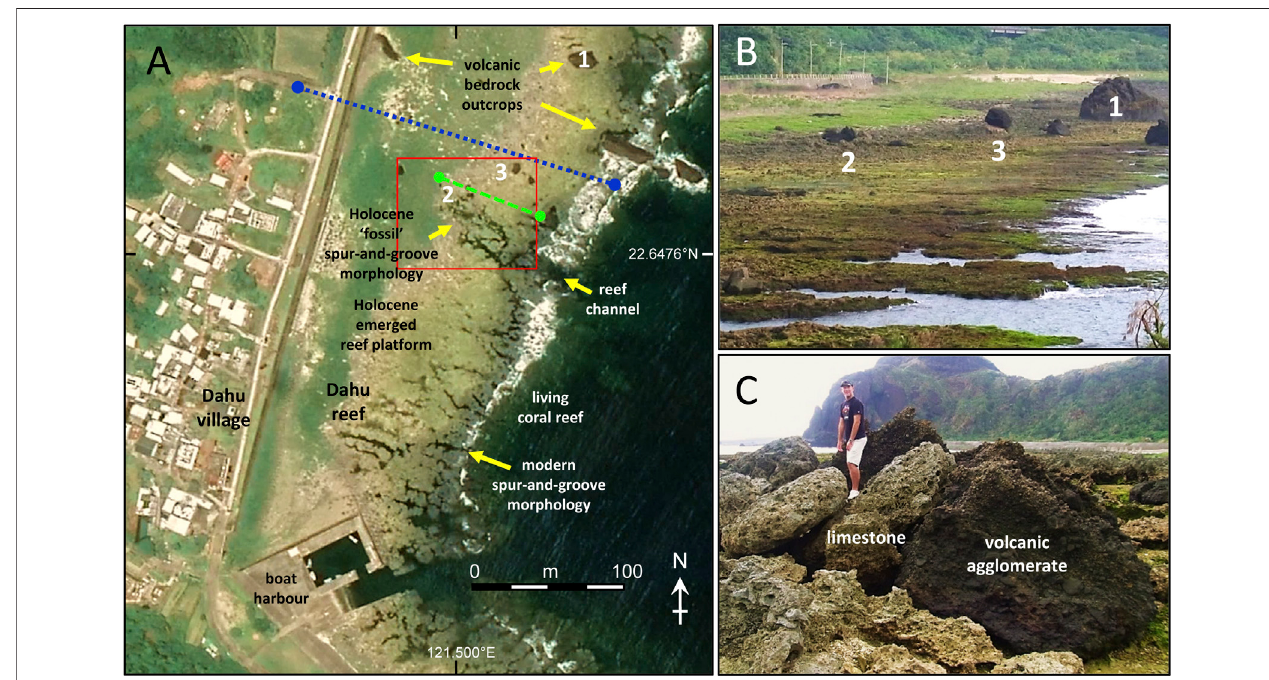
FIGURE 3 | (A) : Main site of coastal boulder measurements on the Holocene emerged reef platform near Dahu village in Wen Cuen Bay, south east Ludao, indicating the location of features shown in adjacent images. Several additional boulders were also measured on the reef platform south east of the boat harbour. Note the modern spur-and-groove structureof the living reefedge and similar “ inherited ” (fossil) structurescutting into the older Holocene surface extending landwards ofthe shoreline. The dotted blue and dashed green lines approximate the topographictransects surveyed by Inoue et al.(2011) and by the authors, shown in Figures 4 , 8 , respectively. The red box shows the zoomed area in air photos ( Figure 10 ). (B) : View looking approximately northward across the coastal platform, showing 1) outcropsofvolcanic bedrock (22 ° 38.92 ′ N121 ° 30.05 ′ ),2) animbricatedclusterofclasts(22 ° 38.88 ′ N121 ° 30.00 ′ E), and 3) avolcanic megaclast perchedon